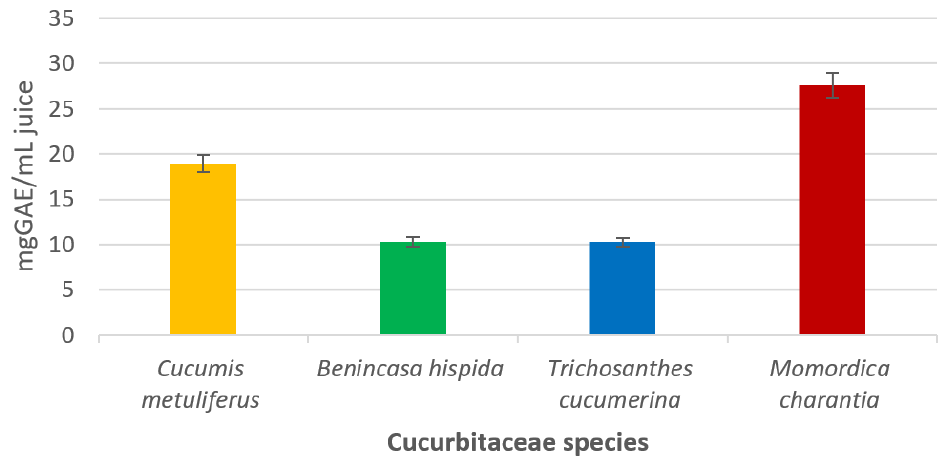
Figure 2. Total polyphenol content of fresh juices. The error bars represent ± standard deviation of three replicates.